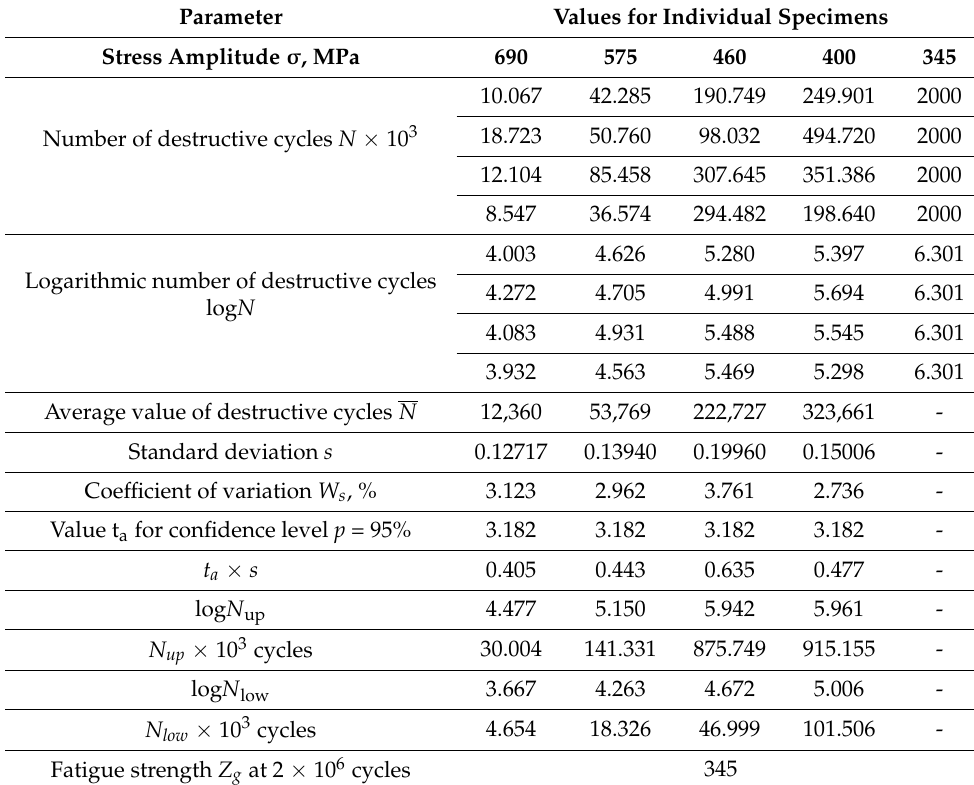
Table 4. Results of the statistical analysis of the fatigue tests for sandblasted specimens.